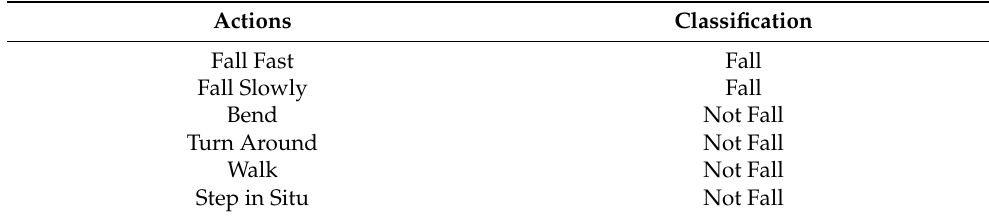
Table 2. Different actions performed by volunteers.